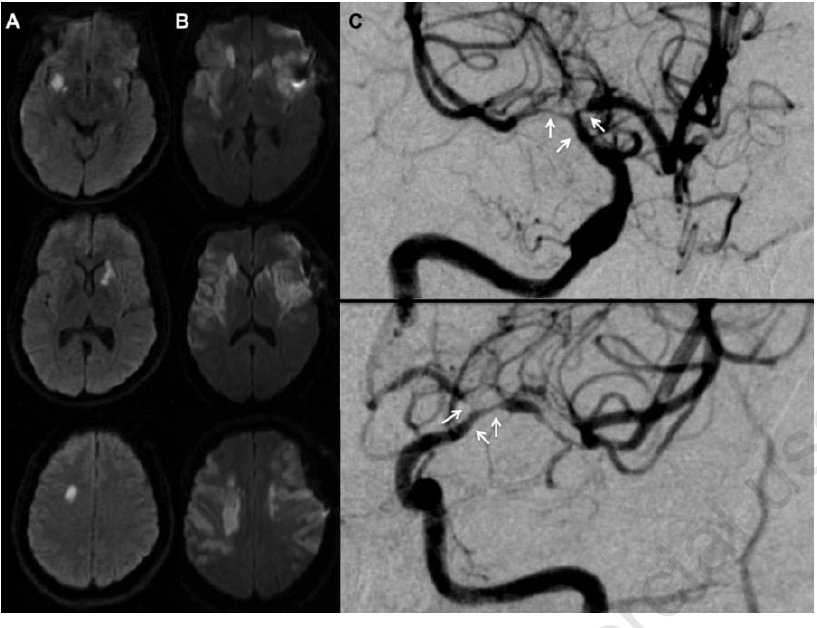
Figure 1. Diffusion-weighted imaging on admission demonstrates acute infarcts in the bilateral middle cerebral artery distributions (A), diffusion-weighted imaging on hospi- tal day 27 shows new infarcts in the bilateral middle cerebral artery distributions (B). Cerebral angiography shows severe stenosis (arrows) of the bilateral distal internal carotid arteries, proximal middle cerebral arteries, and anterior cerebral arteries in both the right (top) and left (bottom) carotid artery injections (C).